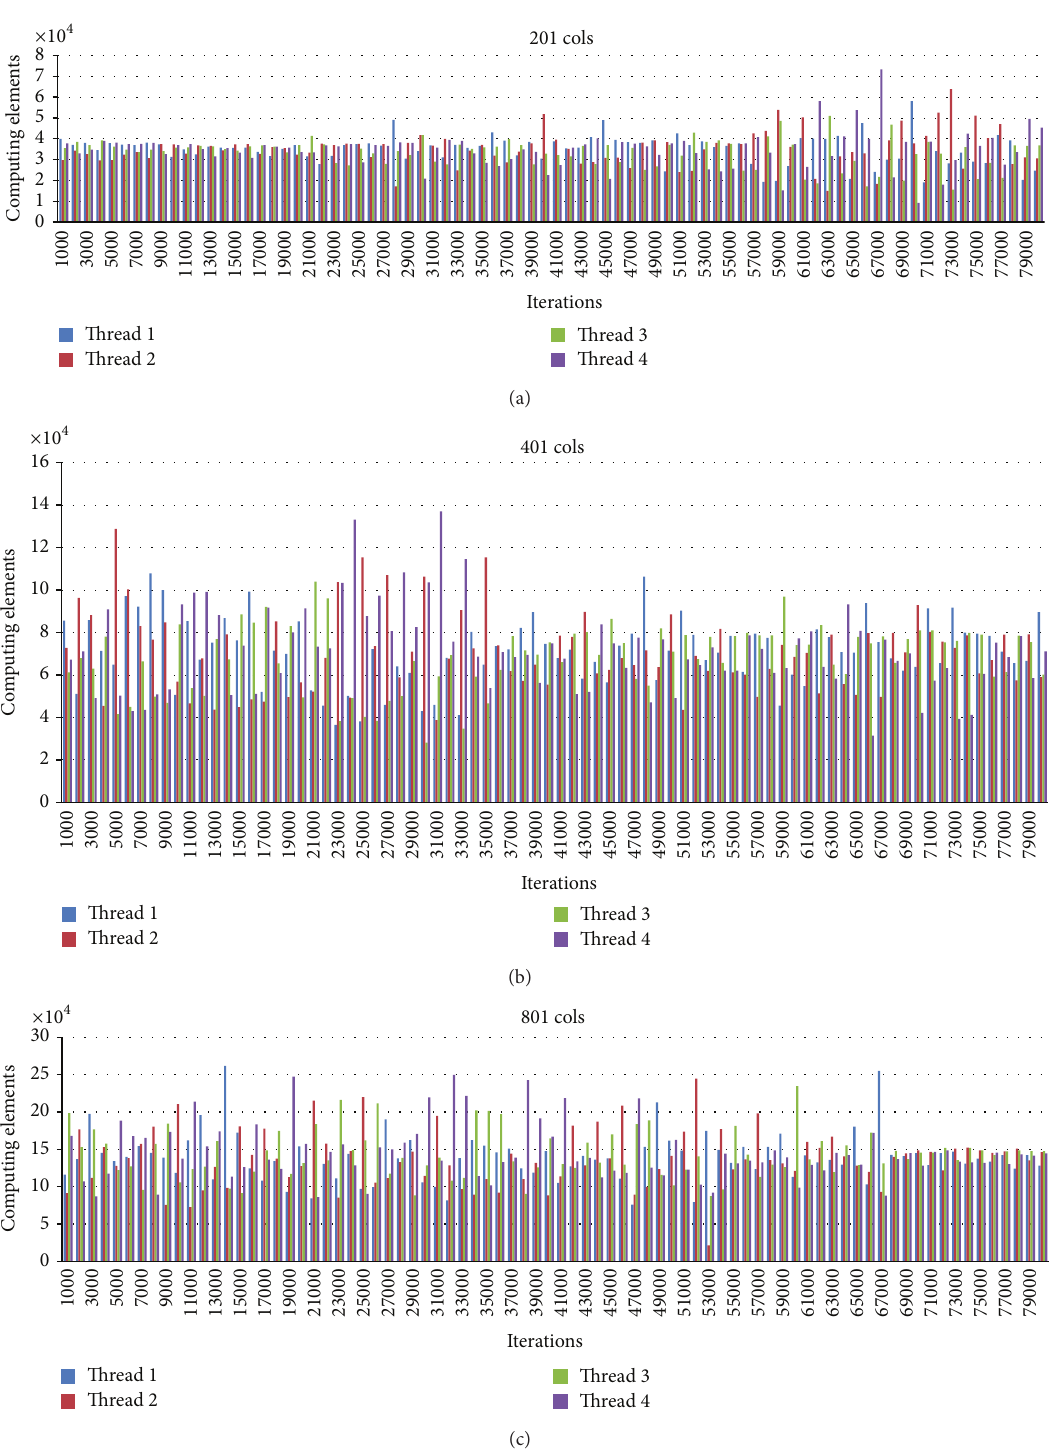
Figure 14: The workload of each thread for 4 threads using dynamic schedule 𝑐ℎ𝑢𝑛𝑘 𝑠𝑖𝑧𝑒 = 1 .